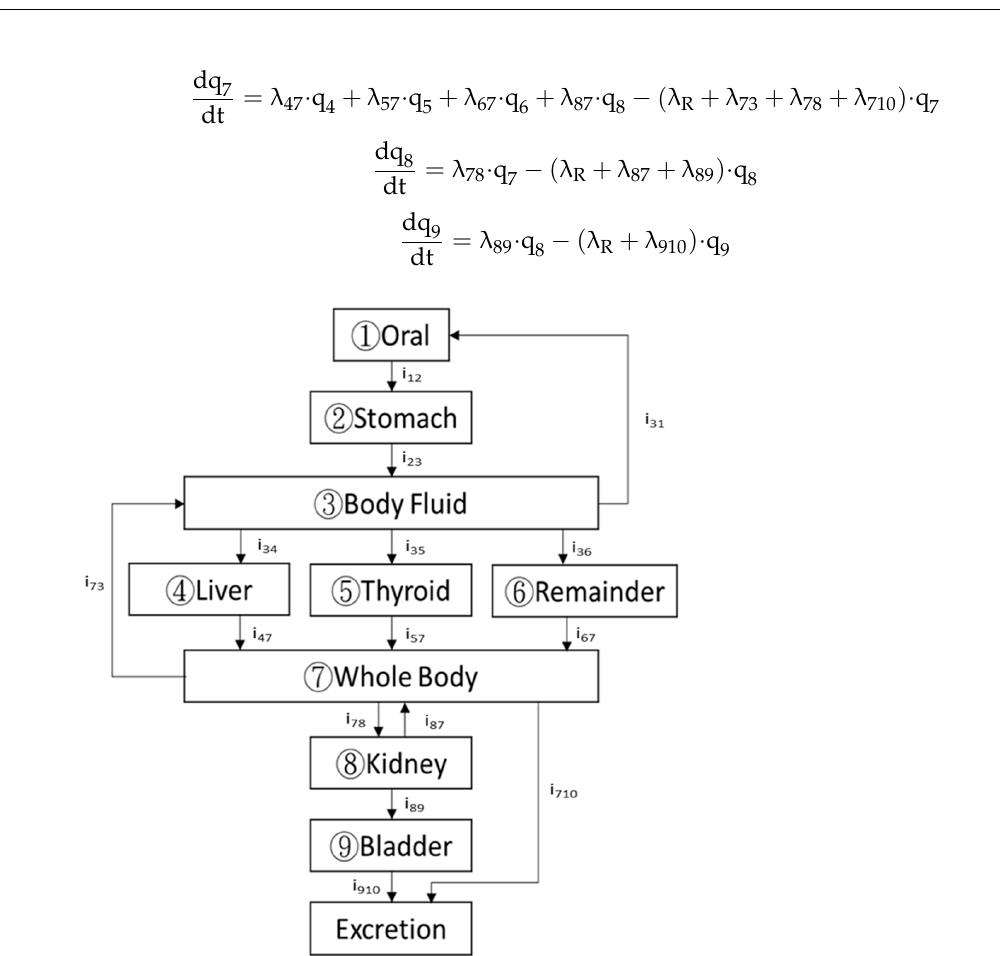
Figure 1. A typical human body can be subdivided into nine major compartments in the biokinetic model of iodine: (1) stomach, (2) body fluid, (3) thyroid, (4) the whole body, and (5) oral, (6) liver, (7) remainder (whole body minus kidney and bladder), (8) kidney, (9) bladder, according to the ICRP-128 report.